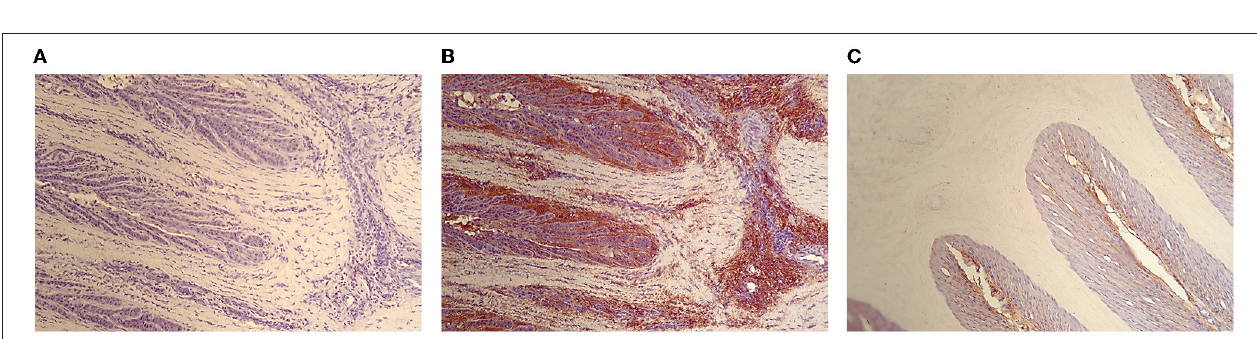
FIGURE 2 | Photomicrograph of the hoof lamellae of a pEHP treated-horse HE staining without primary MPO antibody (A) and HE staining with complete MPO immunohistochemical protocol (B,C) ( × 100).